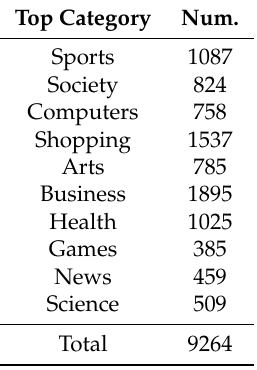
Table 3. Number of multimedia web document for each category in DMOZ